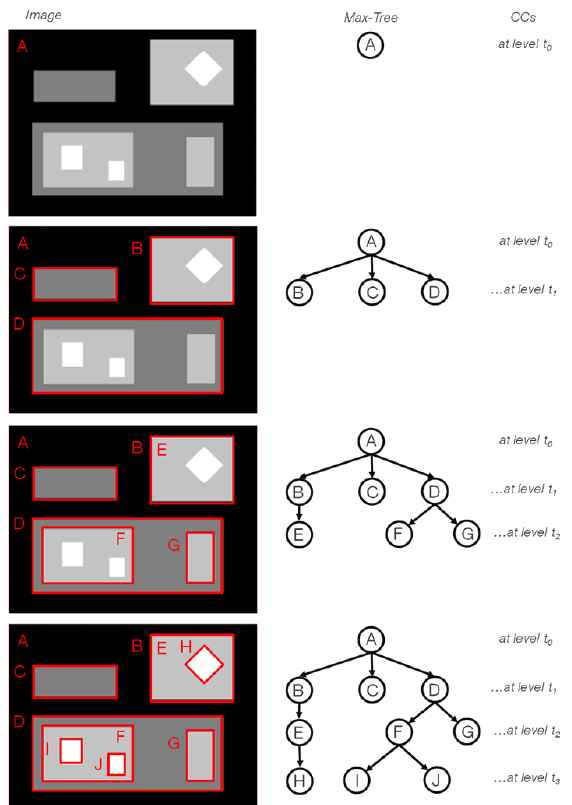
Figure 1. Example of a MT-MP from a synthetic image. The CCs are groups of neighbouring pixels whose values are above the level’s threshold (represented in red at the images on the right). On the left side the corresponding hierarchically structured tree is